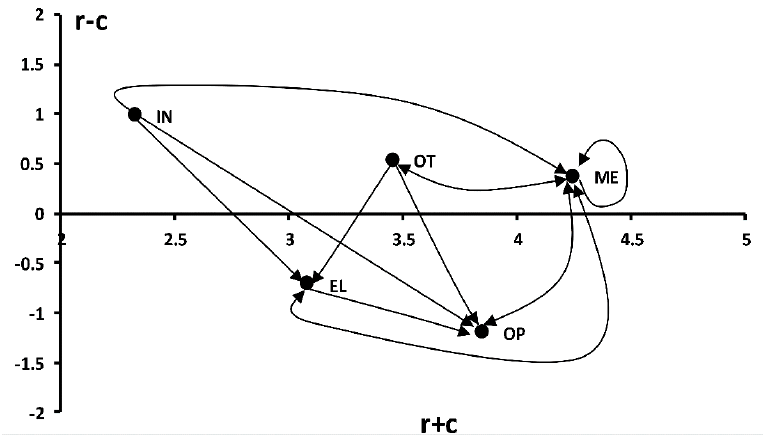
Figure 2. The cause and effect relationship map for the main clusters.